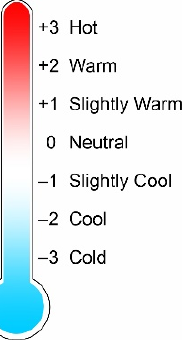
Figure 1. Seven-point thermal sensation scale.